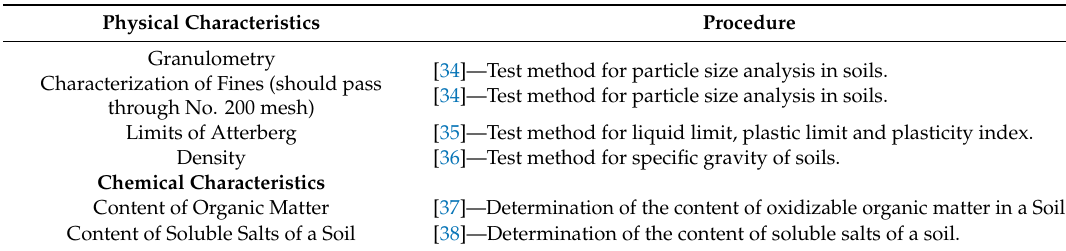
Table 1. Characterization of excavation material.